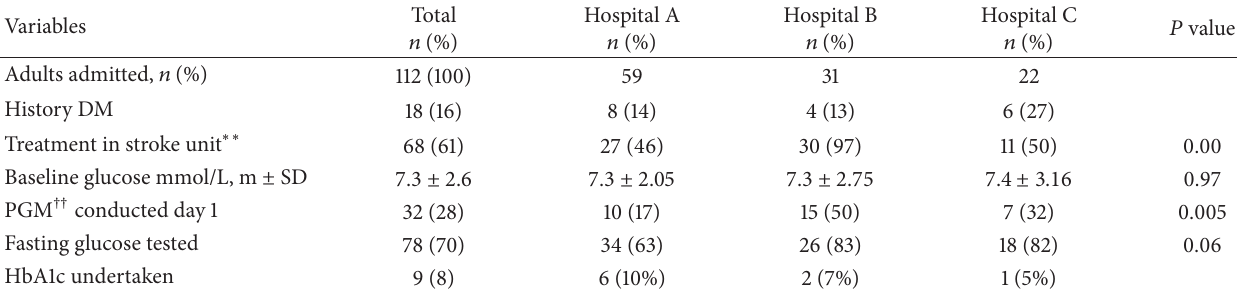
Table 3: Glucose monitoring practice and between adults admitted to hospitals A, B, and